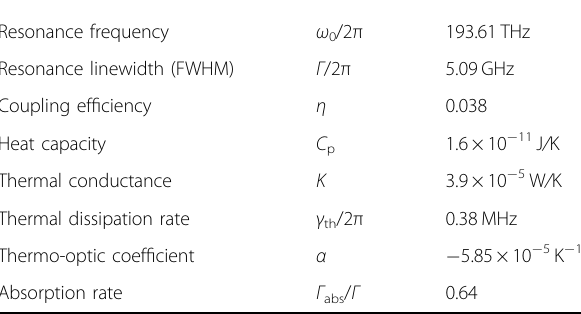
Table 1 Physical parameters estimated for